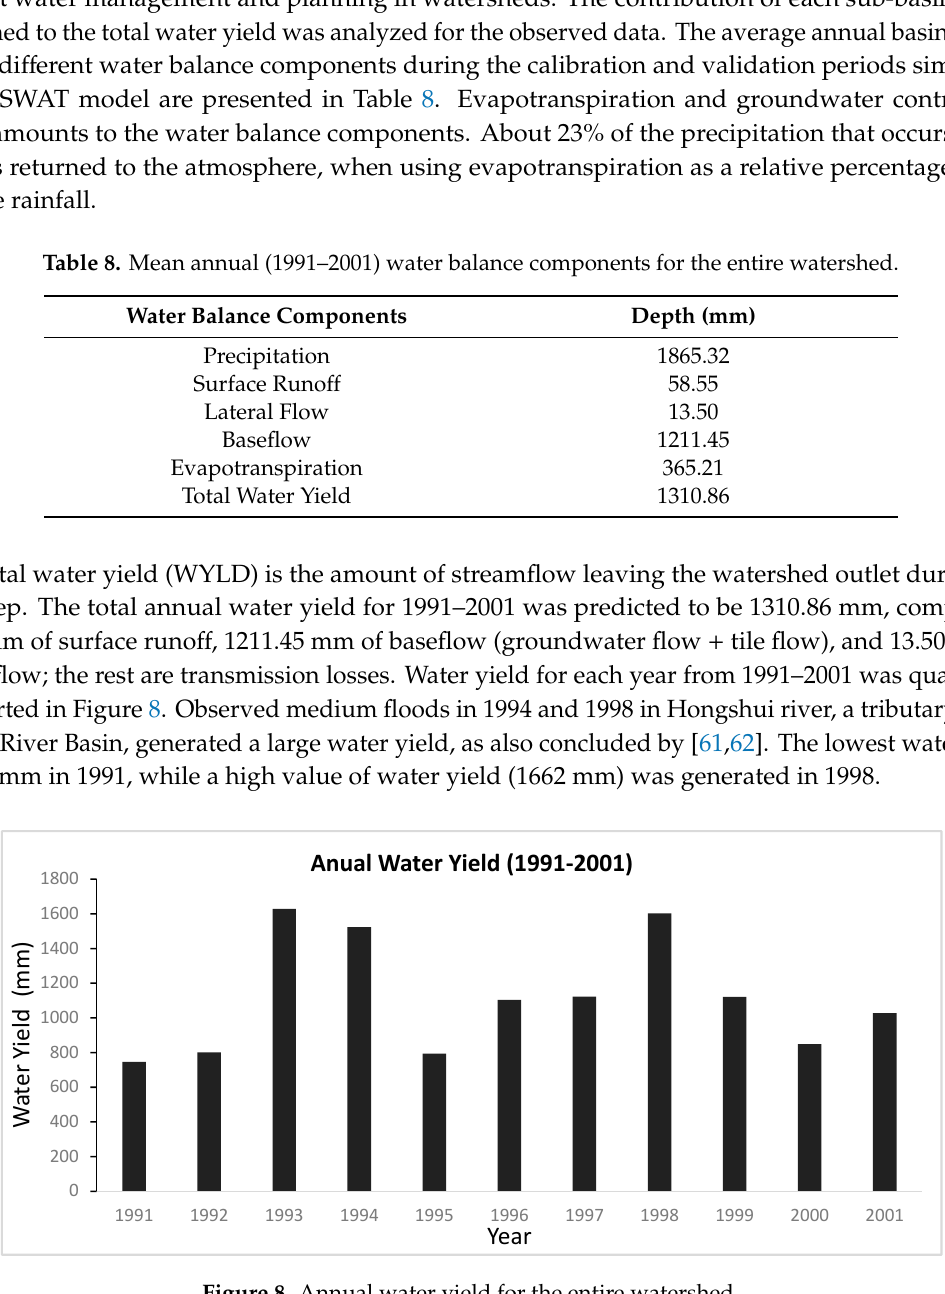
Table 7. Mean monthly historical (1971–2001) and future (2020–2050) discharge (cm 3 /sec) and percent change of global climate models (GCMs) under all four future scenarios.